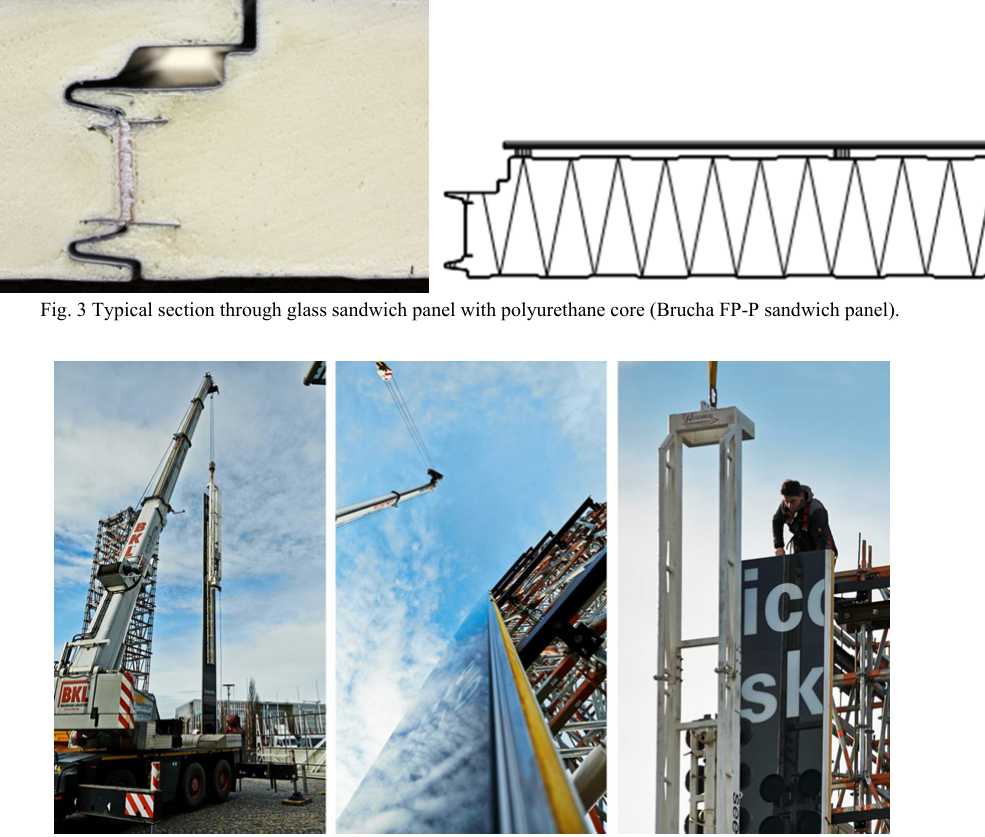
Fig. 4 Erection of glass sandwich panels at Munich BAU fair